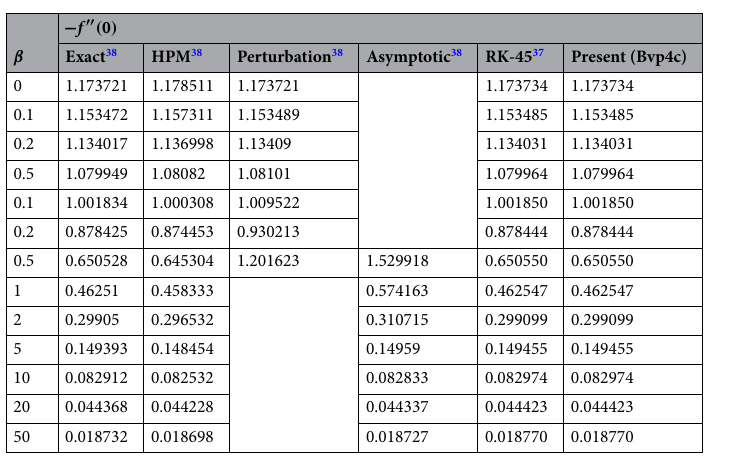
f ′′ ( 0 ) for different values of the velocity −